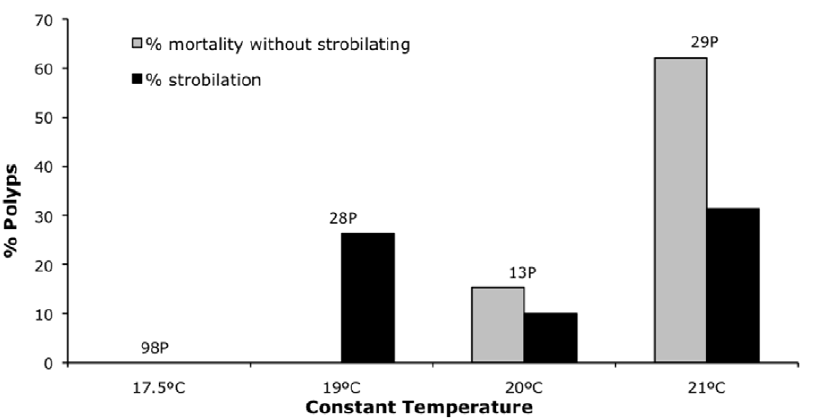
Figure 5. Strobilation at constant temperature (Experiment F). Previously, polyps were acclimated to a constant temperature (17.5, 19, 20 and 21 u C) for 35 days without iodine in the water. Accumulate strobilation percentage of polyps and proportion of polyps that died without strobilating after 15 days of adding iodine, keeping the polyps at the same temperature at which they were acclimated. No polyps strobilated or died at 17.5 u C. The total number of polyps at the beginning of the experiment is indicated.